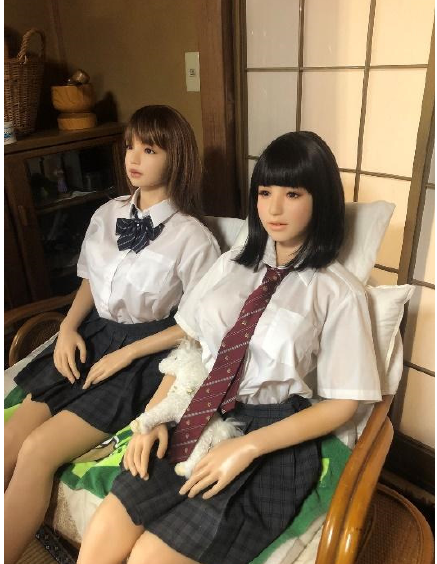
Figure 3 . Love dolls owned by Mr. Nakajima (Source: Photograph taken by the authors with the permission from the owner).